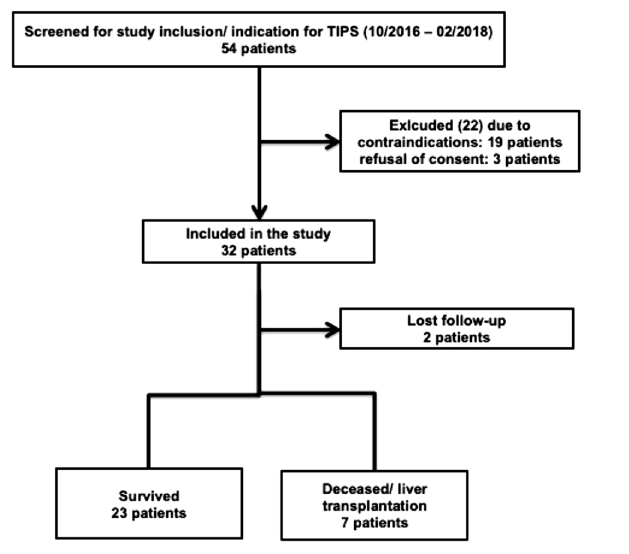
Figure 1. Patient